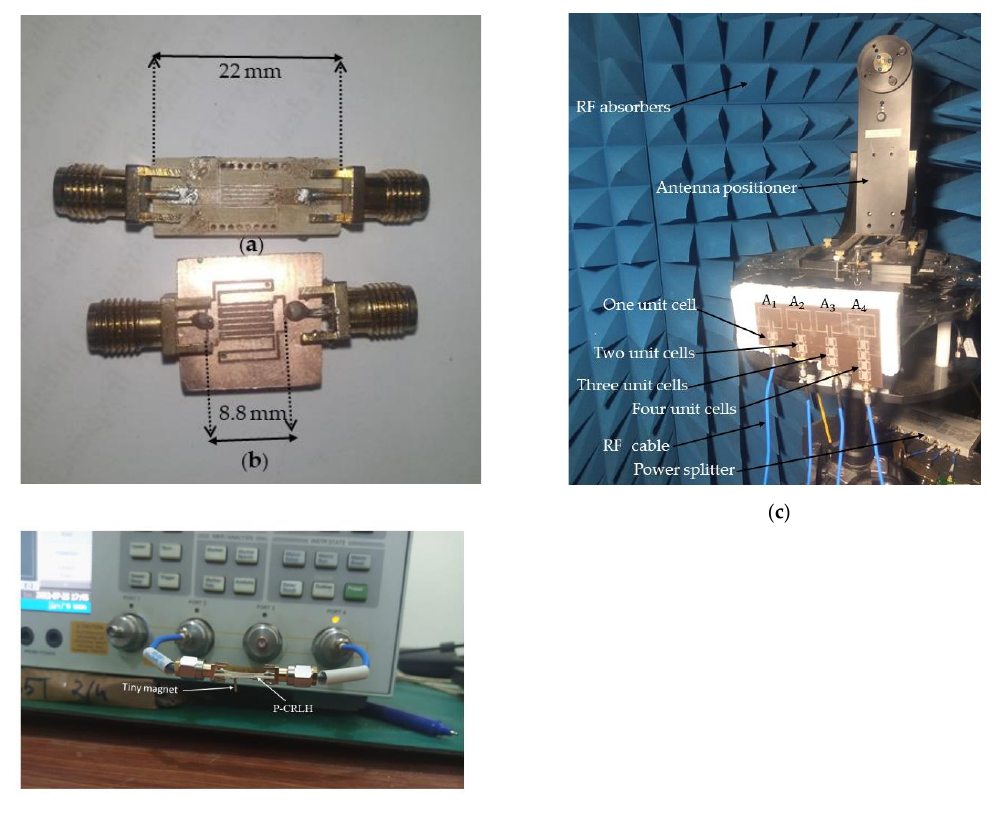
Figure 13. Photographs of the fabricated ( a ) unit cell P-CRLH phase shifter reported in [29]; ( b ) proposed unit cell P-CRLH phase shifter; ( c ) a 1 × 4 linear phased array with integrated proposed P-CRLH phase shifters in an anechoic chamber and ( d ) unit cell P-CRLH phase shifter measurements .